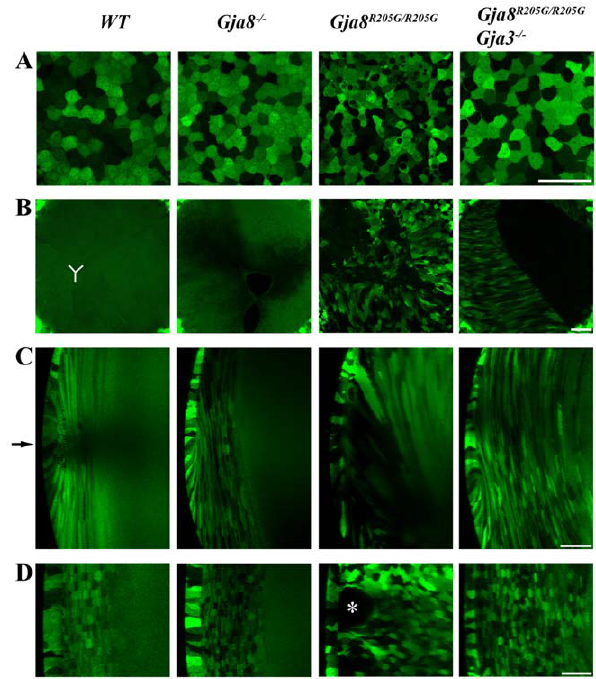
Figure 4. Confocal imaging of GFP-positive (GFP + ) live lenses from wild-type ( WT ), Gja8 knockout ( Gja8 2 / 2 ), Gja8 R205G homo- zygous mutant ( Gja8 R205G/R205G ) and Gja8 R205G Gja3 double mutant ( Gja8 R205G/R205G Gja3 2 / 2 ) mice at the age of 2 weeks. ( A ) Confocal images showed the typical mosaic pattern of GFP in lens central epithelial cells in all lenses examined. Aberrant epithelial cells appeared only in the Gja8 R205G/R205G lens. ( B ) Images displayed the anterior Y-suture (delineated by the white lines in the WT lens) where the ends of underlying fiber cells come into contact. These elongated fiber cells in the WT lens had normal uniform GFP signal. There was a partial delay in Y-suture closure in the Gja8 2 / 2 lens. In the Gja8 R205G/ R205G mutant lens, aberrant GFP + cells were observed in the open suture region where the opposing fiber cells failed to elongate fully to close the anterior Y-suture. The Gja8 R205G/R205G Gja3 2 / 2 double mutant lens also had an open suture (black area) due to insufficient fiber cell elongation. ( C ) An anterior (top) to posterior (bottom) sectional view from three-dimensional z-stack reconstructions of GFP + lenses showing the lens equator (indicated by an arrow) and peripheral fiber cells. Only Gja8 R205G/R205G homozygous lenses displayed disorganized fiber cells. Scale bars, 50 m m. ( D ) A cross sectional view from three-dimensional reconstructions of z-stacks of GFP + lenses at the lens equator. Lens epithelial cells are on the left. In the WT lens, peripheral fiber cells were precisely organized and displayed a mosaic GFP expression pattern while inner fiber cells showed uniform GFP signal. In the Gja8 2 / 2 lens, peripheral fiber cells remained organized. In the Gja8 R205G/R205G homozygous mutant lenses, peripheral fiber cells were completely disorganized with vacuole-like structures or enlarged extracellular spaces (indicated by an asterisk). However, in Gja8 R205G/R205G Gja3 2 / 2 double mutant lenses, peripheral fiber cells were mainly organized.